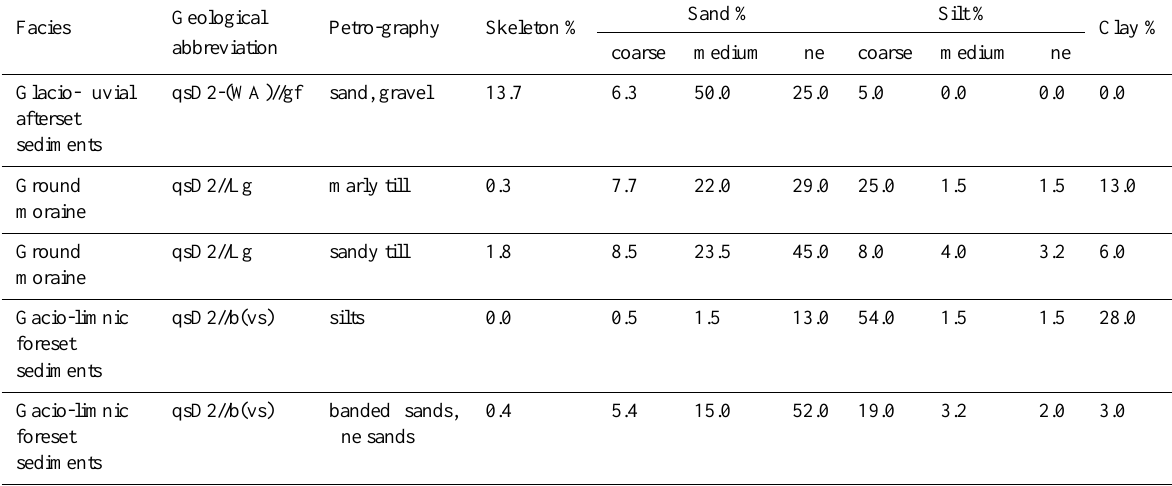
Table 3. Properties of the principal types of parent material from the excavation site. Values based on data courtesy of VEM. Sand % Silt % Geological Facies Petro-graphy Skeleton % coarse medium coarse medium